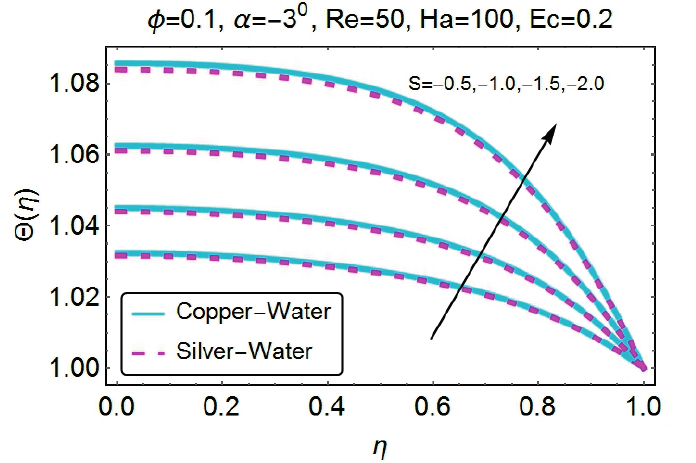
Figure 22. Change in temperature for varying S (convergent channel/stretching case).